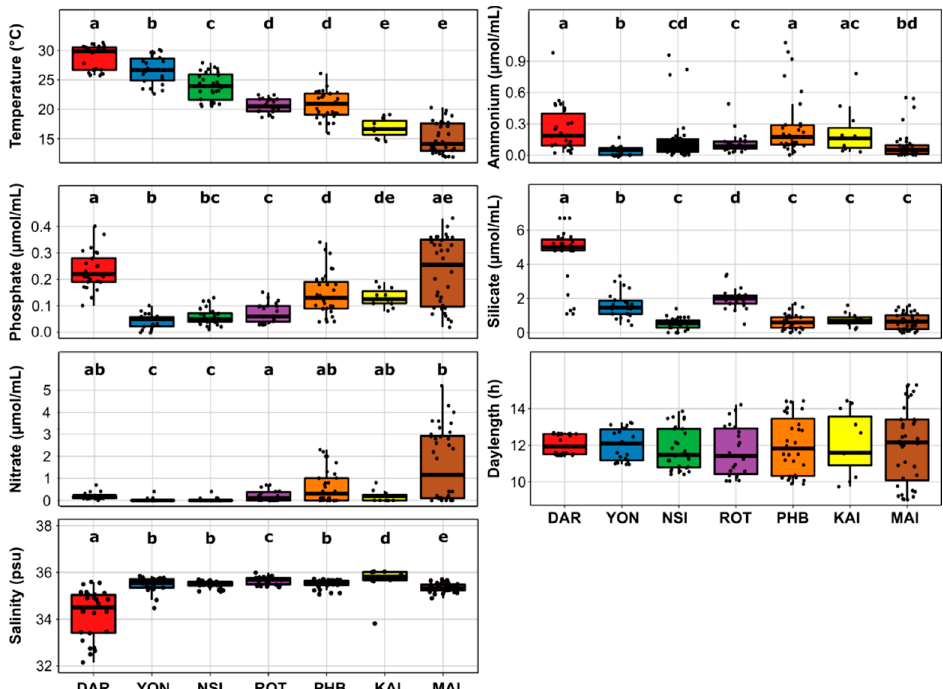
Figure 2. Variability of Environmental Variables Across the Seven Time-Series Sites. Lower and upper limits on each boxplot represent the first and third quartile (25th and 75th percentiles), the median is represented by the solid black line within the box. The whiskers represent the largest and smallest value no further than 1.5 times Interquartile Range (IQR). Different letters (a, b, c, d, e) indicate a significant difference between the associated means (Wilcoxon rank sum test p < 0.05). Darwin had 26 datapoints (only 25 for phosphate and nitrate analysis), Yongala 22, North Stradbroke Island 26 (only 25 for ammonium), Port Hacking 31 (30 for ammonium), Maria Island 36, Kangaroo Island 11 and Rottnest Island 22. Each site is represented by a different colour.